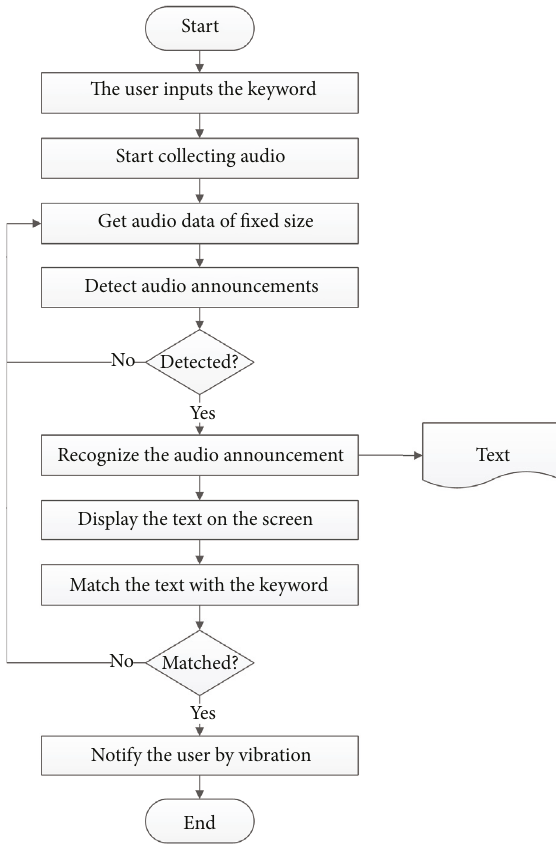
Figure 2: Flowchart of the proposed system.